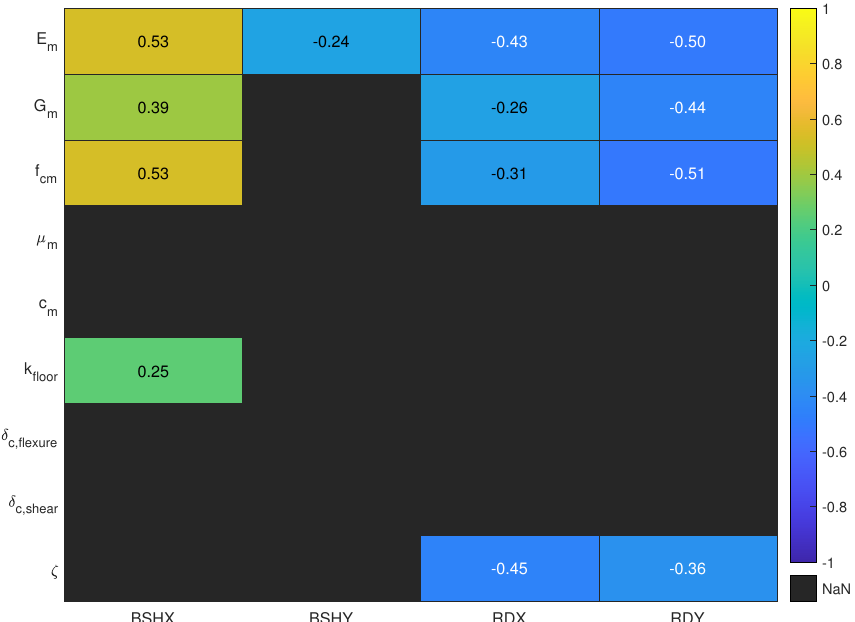
Figure 21. Lausanne Malley model (with out-of-plane disabled and rigid connections) Spearman correlation matrix for PGA 0.105